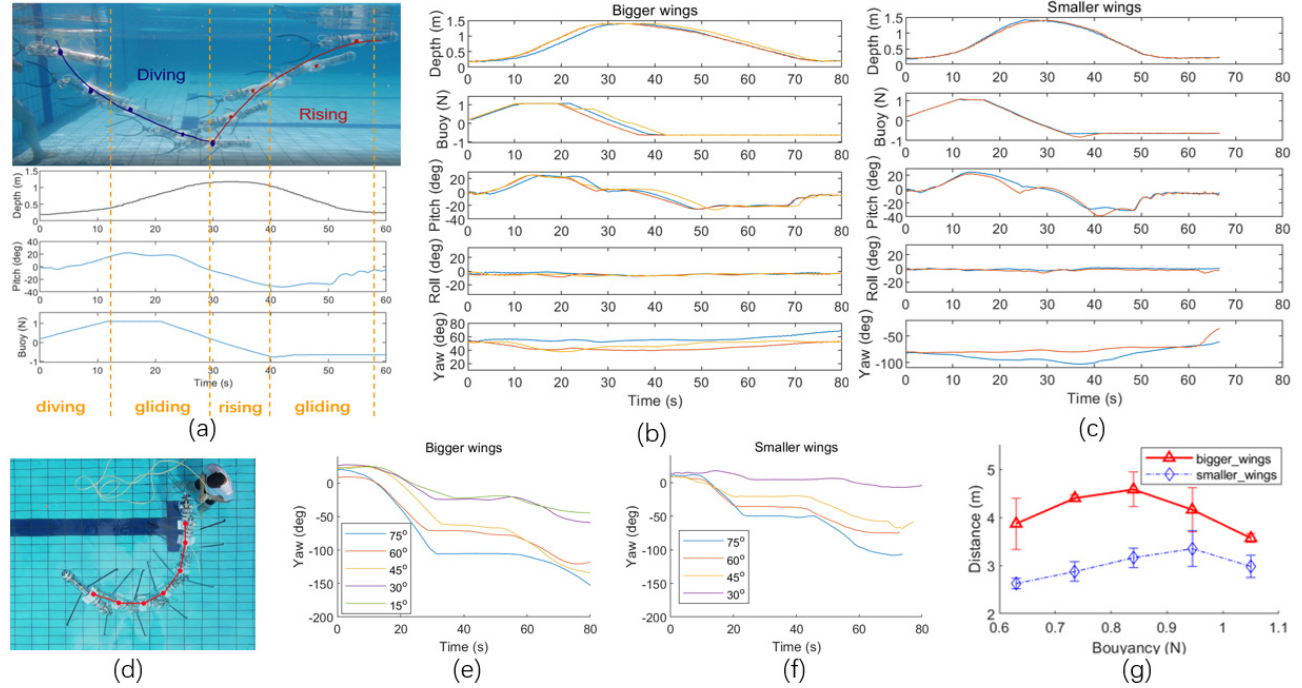
Figure 6. Field test results. The MAG-2 was tested in the pool with turning, gliding, different wing size, and different MCM-I control conditions. ( a ) The tracking result, with the tracker and corresponding recorded states data. The state data were recorded during tests with different size wings, and the result is shown in subfigures ( b , c ). Besides, different colors here represent different times of tests. ( d ) The tracking result from the aerial view. During the tail angle turning tests, with different wings, the yaw angle of the gilder (in the world coordinate) was recorded timely, and results are shown in subfigures ( e , f ). The distance that the glider can reach in one cycle was recorded, with different control strategies and wings, and the result is shown in subfigure ( g ).